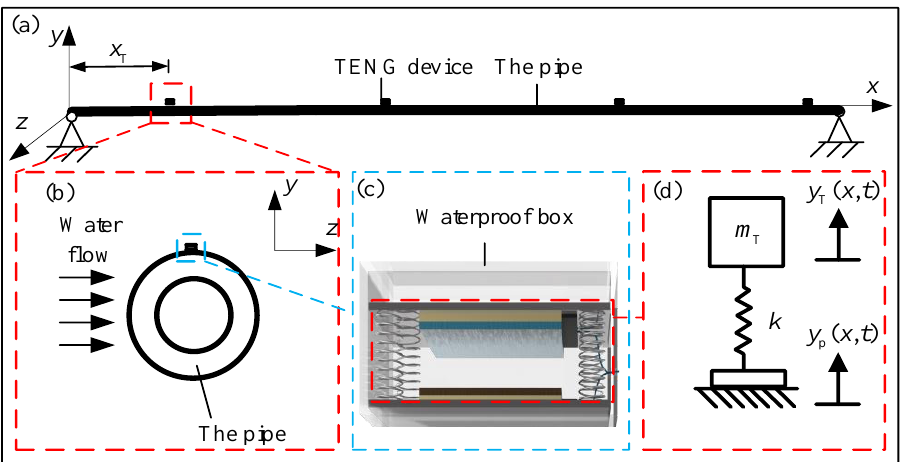
Figure 6. Schematic design of the pipe host. ( a ) the integral pipe which is assumed to be a simply supported beam; ( b ) the cross section of the pipe; ( c ) TENG device sealed by a water-proof box; ( d ) the schematic design of mass-spring base of TENG device.